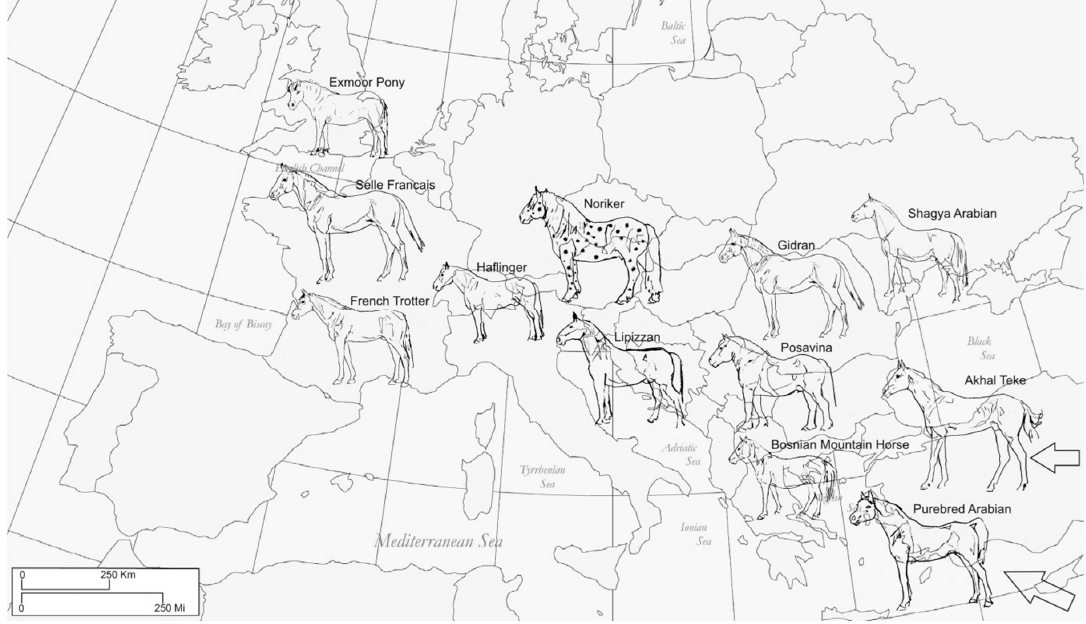
Figure 1. Geographic origin of twelve investigated European and Near Eastern horse breeds (Graphics Thomas